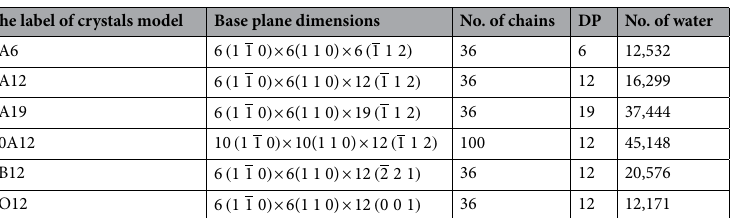
Table 1. Dimensions and number of molecules for the six types of cellulose II nanocrystal models.